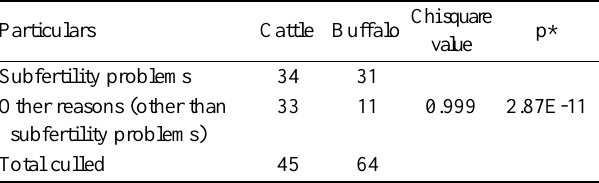
Table 4. Chi-square test to study the effect of subfertility problems on disposal of bulls